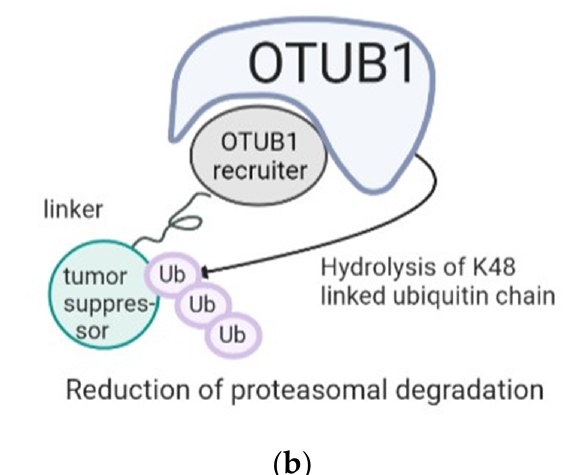
Figure 2. DUBTACs as promising anti-cancer approaches. ( a ) Mechanism of action of DUBTACs that hydrolyze pro-degradative ubiquitin chains attached to a target to reduce recruitment of the cargo protein to the proteasome, thus reducing its degradation. ( b ) Hypothetical design using DUBTACs to recruit OTUB1 as a strategy to stabilize tumor suppressors through deubiquitination of K48-bound ubiquitin chains.